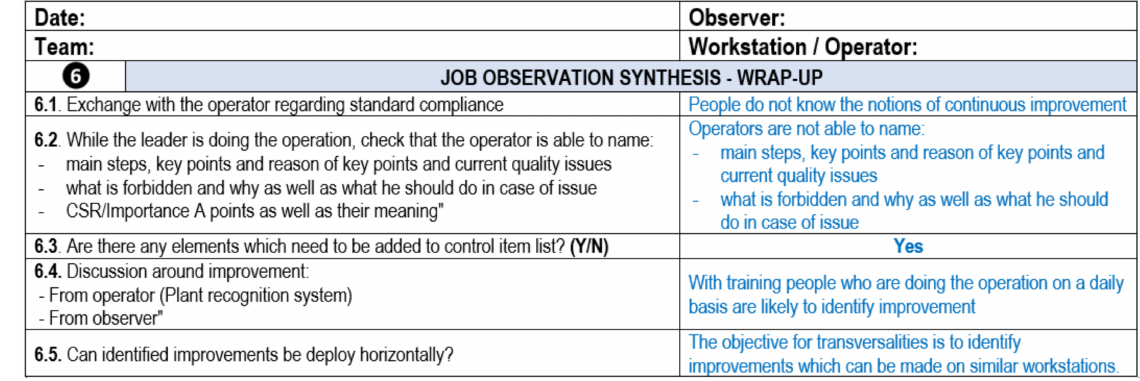
Figure 21. JobObservation synthesis of the production system “plastic injection”.